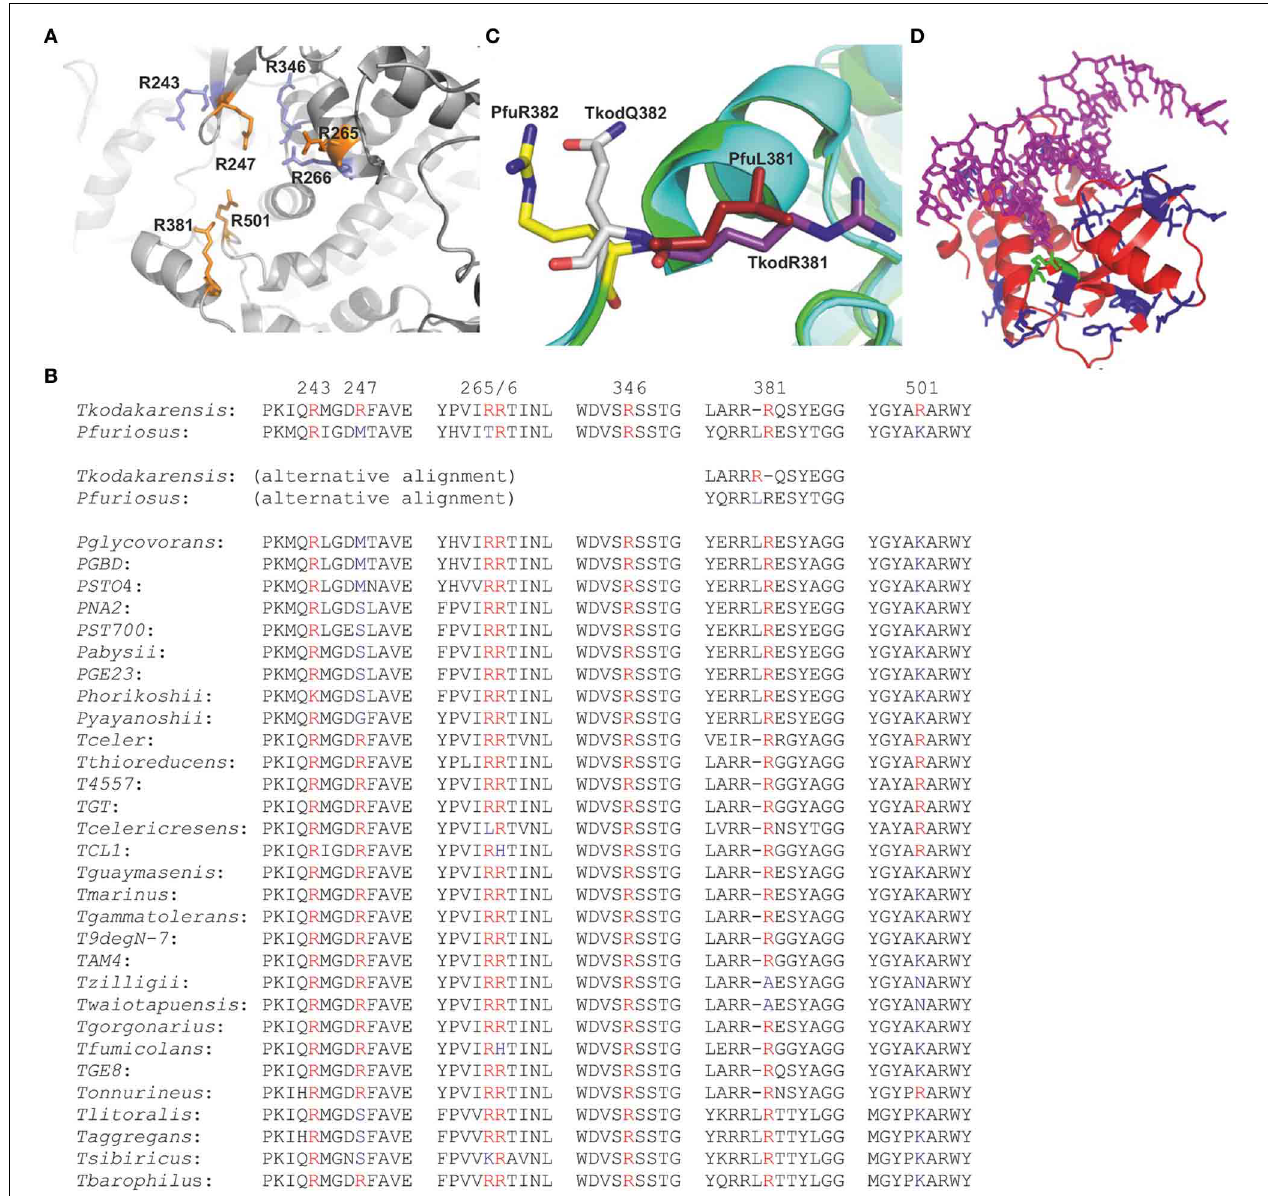
FIGURE 1 | “Forked-point” arginines in family-B DNA polymerases from the Thermococcales order of the archaea. (A) Close spatial proximity of the forked-point arginines in Tkod-Pol (pdb; 1GCX). The arginines shown in orange are not conserved in Pfu-Pol and are the subject of this study. The arginines shown in blue are present in both Tkod-Pol and Pfu-Pol. (B) Amino acid sequence line up of the “forked-point” arginines and their immediate neighbors. The seven arginines present at the forked-point of Thermococcus kodakarensis DNA polymerase are shown in red and their position in the polypeptide chain indicated by the numbers above the sequence. Retention of arginine in other polymerases is indicated in red, change to an alternative